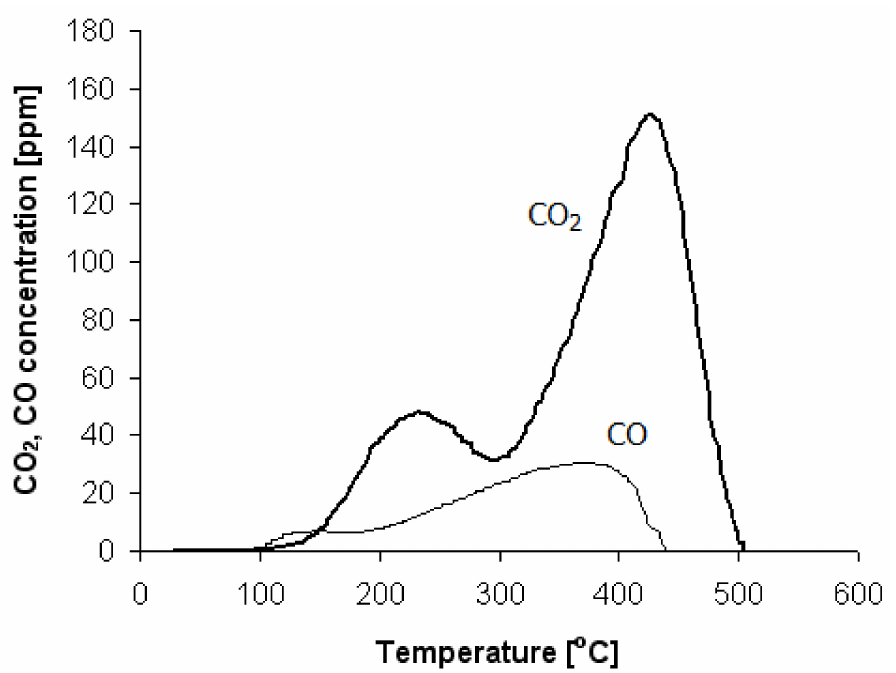
Figure 4. The CO 2 and CO concentration profile changes obtained during the TPD-CO process over the S500 sample recorded simultaneously during the same